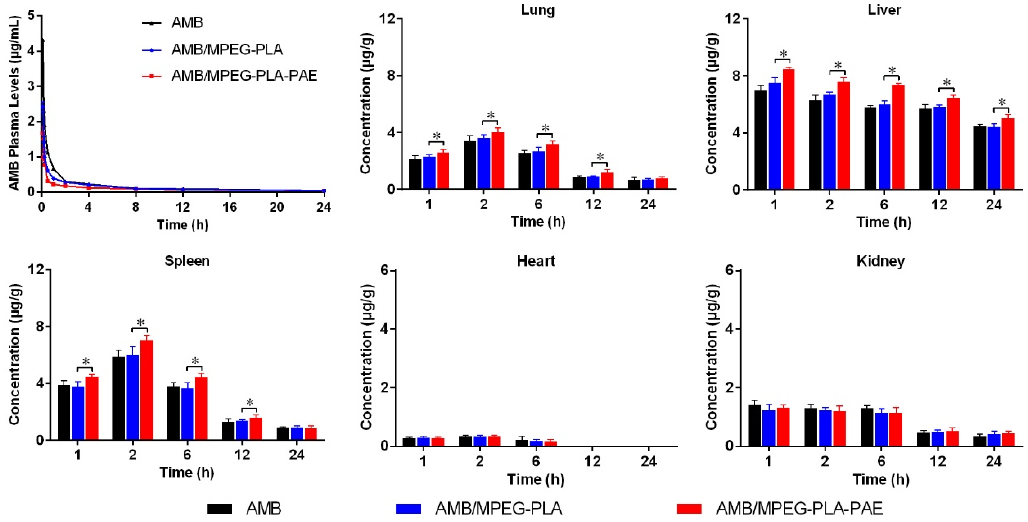
Figure 5. Plasma concentration ‐ time curves and biodistribution after intravenous administration of AMB ‐ loaded injection solution, micelles, and complex. Six rats from each group were used for pharmacokinetic studies at a dose of 1 mg AMB/kg body weight via intravenous route. For biodistribution studies, three mice at each time point were sacrificed after intravenous administration of each formulation of a dose of 1 mg AMB/kg body weight. Significant differences in tissue drug content (lung, liver, and spleen) between the AMB/MPEG-PLA and AMB/MPEG-PLA-PAE group are indicated with * p < 0.05 (data represented as the mean ± SD).